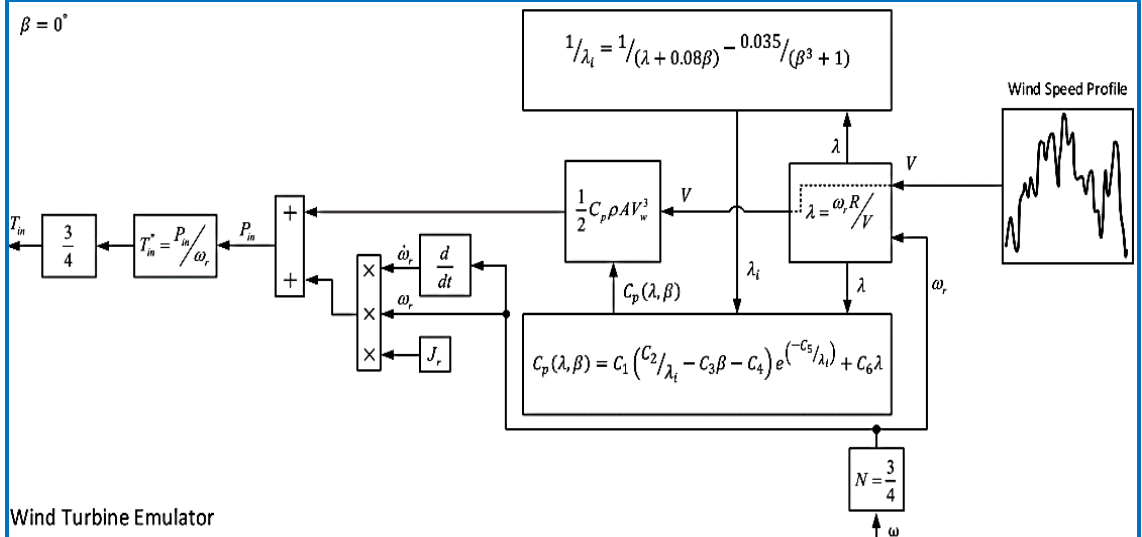
Figure 4. Wind turbine Emulator.